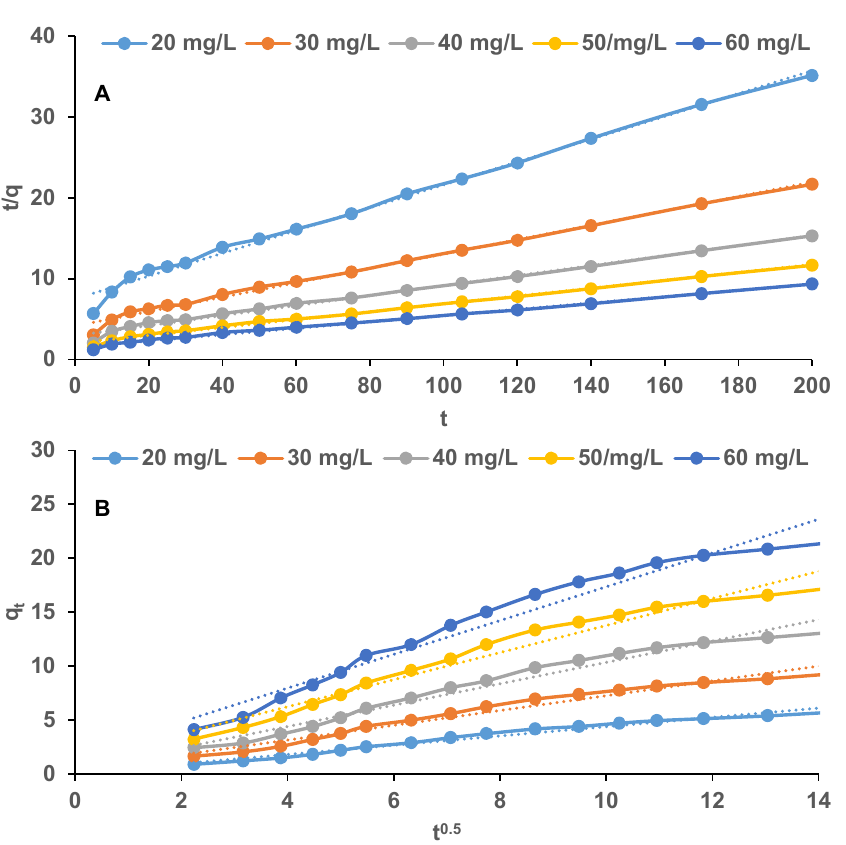
Figure 7. Pseudo-second-order ( A ) and intraparticle diffusion ( B ) kinetic models for the biosorption of EL on the synthesized biosorbent. Table 1. Biosorption kinetic parameters of EL on synthesized biosorbent.